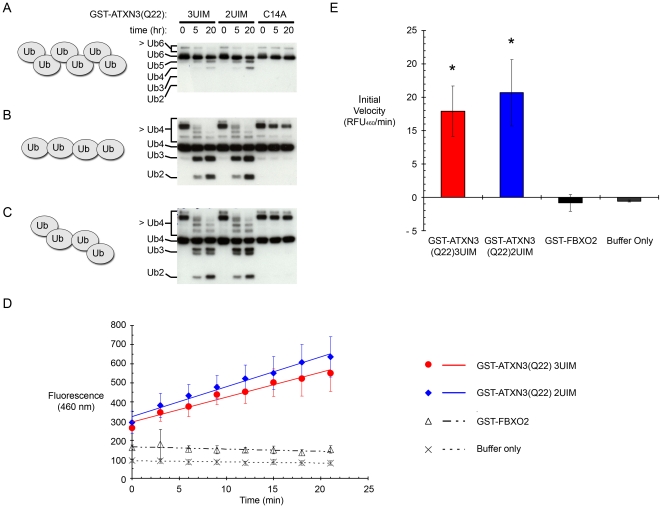
2UIM and 3UIM ataxin-3 display similar DUB activity against defined ubiquitin chains in vitro.(A–C) Recombinant GST-ATXN3(Q22) (3UIM or 2UIM) can cleave K48-linked hexaubiquitin (A), K63-linked tetraubiquitin (B), and mixed linkage K48-K63-K48 tetraubiquitin (C) chains. Results with catalytically inactive GST-ataxin-3 (C14A mutant) are also shown. (D–E) Recombinant 2UIM and 3UIM GST-ATXN3(Q22) cleave Ub-AMC at a similar rate. (D) Ub-AMC reaction curves. Both 3UIM and 2UIM ataxin-3 area able to cleave Ub-AMC, while reactions with either an unrelated control protein (the non-DUB F-box protein FBXO2) or buffer only show no cleavage. Error bars show standard deviations. (E) There is no significant difference between the initial reaction velocity of 2UIM and 3UIM ataxin-3(Q22) (p>0.4 by a 2 tailed heteroscedastic Student's t-test).